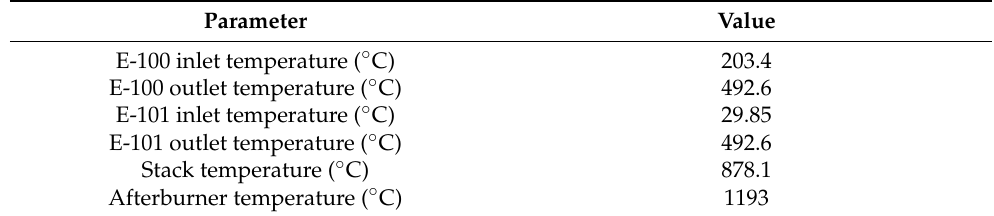
Table 7. Detailed operating conditions of the SOFC system under the conditions of maximum power.